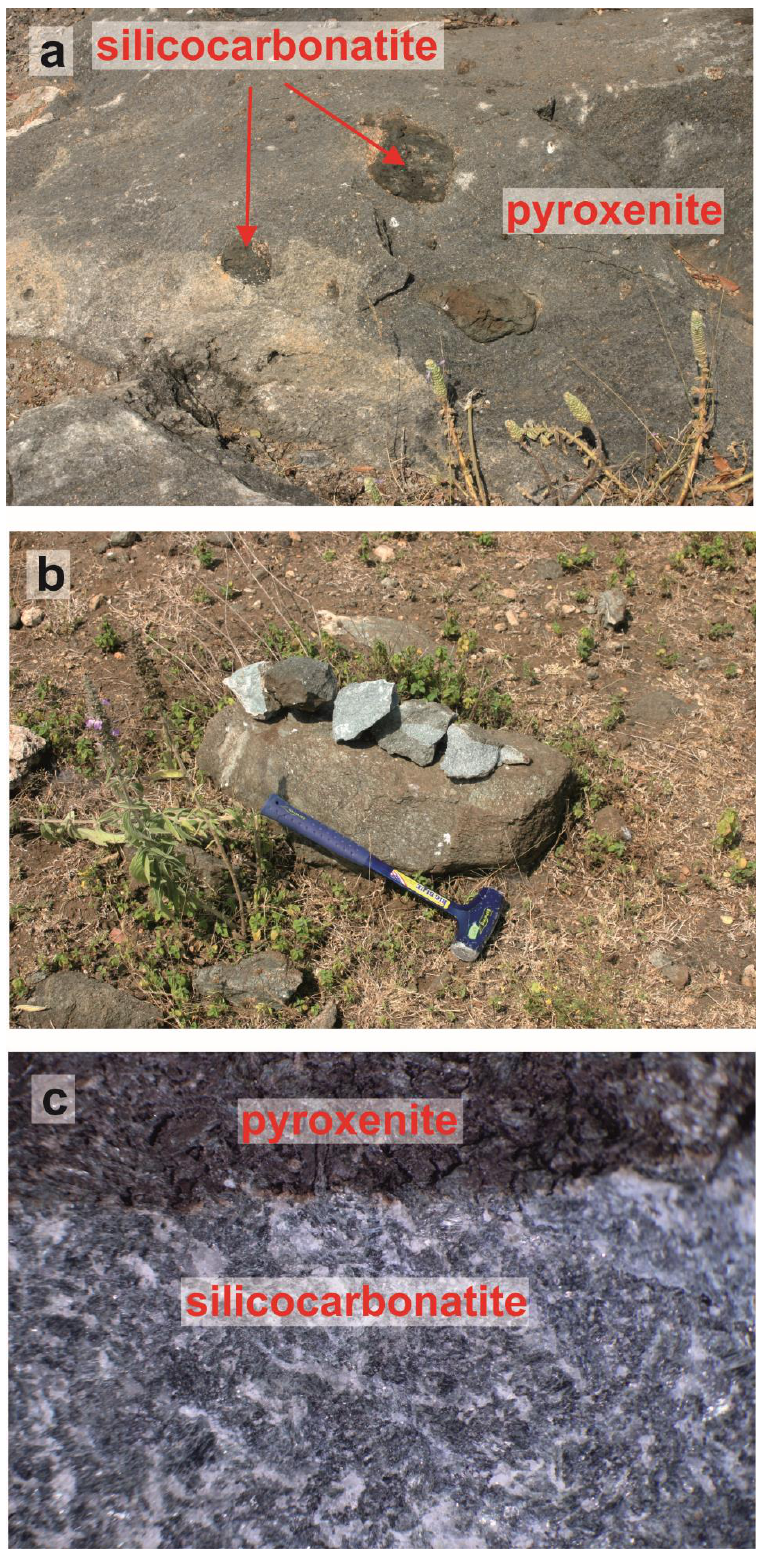
Figure 2. Occurrences of silicocarbonatite enclaves in pyroxenites of Samalpatti complex: ( a ) sampling site IC04, ( b ) sampling sit IC03, ( c ) detail of silicocarbonatite with hosting pyroxenite. Pictures ( b , c ) are adapted from Ackerman et al. [16].